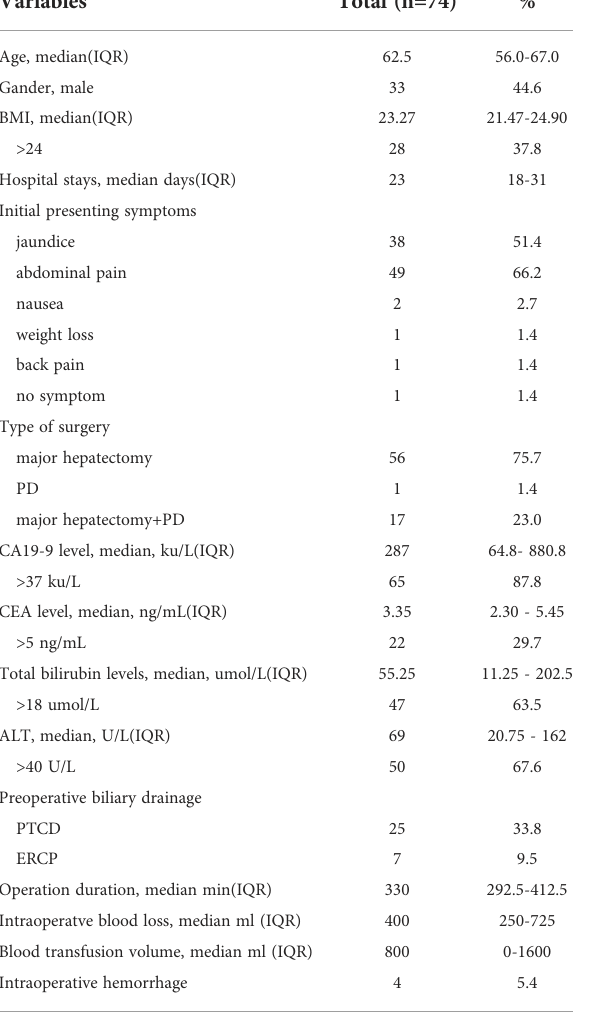
TABLE 2 The pathological outcomes and long-term follow up data of gallbladder cancer patients who underwent extended resection.